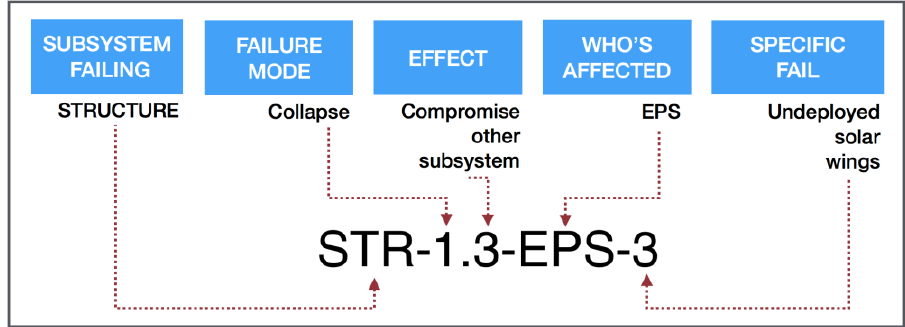
Figure 5. Example of the code used to identify the failures.